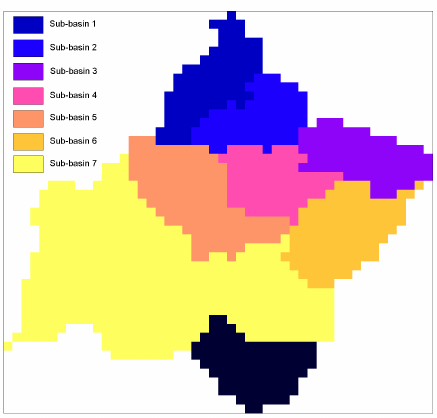
Map of the 7 different zones used for the assimilation experiments on the Morava basin (the black part was not taken into account for the particle filter). The data assimilation experiments on the area upstream of the Kromericz station only include the zones 1, 2, 3 and